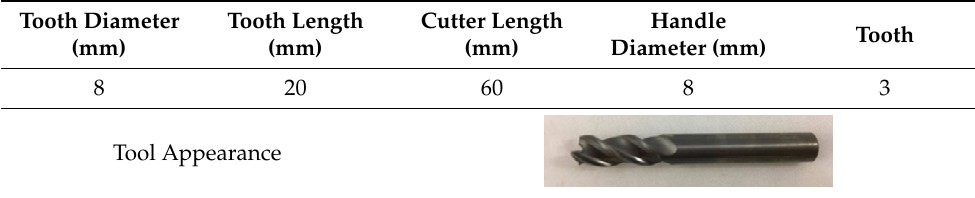
Table 7. Factors and levels used in the experiments.